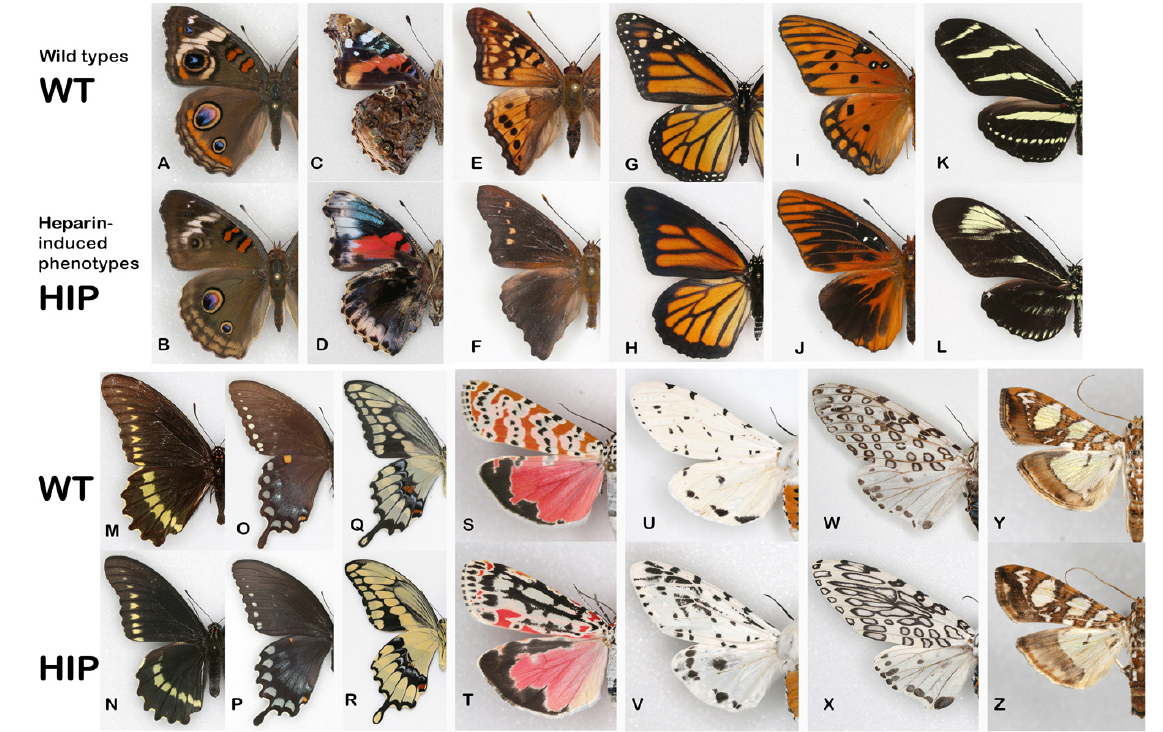
Figure 1. The experiment at a glance: wild types (WT) vs. heparin-induced phenotypes (HIP) in 13 species of Lepidoptera from four families. ( A , B ) The common buckeye ( Junonia coenia ); ( C , D ) the red admiral ( Vanessa atalanta ); ( E , F ) the tawny emperor ( Asterocampa clyton ); ( G , H ) the monarch ( Danaus plexippus ); ( I , J ) the gulf fritillary ( Agraulis vanillae ); ( K , L ) the zebra longwing ( Heliconius charithonia ); ( M , N ) the polydamas swallowtail ( Battus polydamas ); ( O , P ) the spicebush swallowtail ( Pterourus troilus ); ( Q , R ) the giant swallowtail ( Heraclides cresphontes ); ( S , T ) the ornate bella moth ( Utetheisa ornatrix ); ( U , V ) the leopard moth ( Hypercompe scribonia ); ( W , X ) the acrea moth ( Estigmene acrea ); ( Y , Z ) the mulberry leaftier ( Glyphodes sibillalis